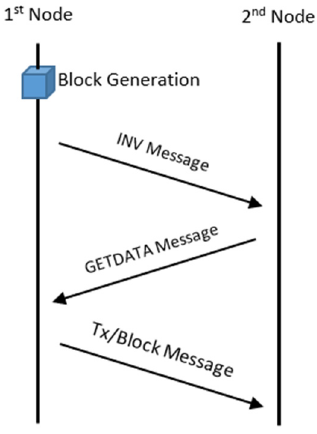
Figure 4. Exchanging message information between